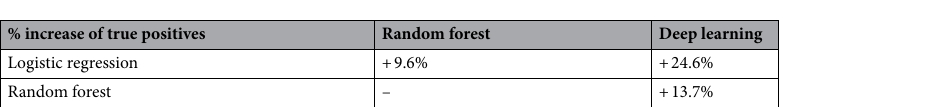
Table 3. Percentage increase in true positive cases by increasing model